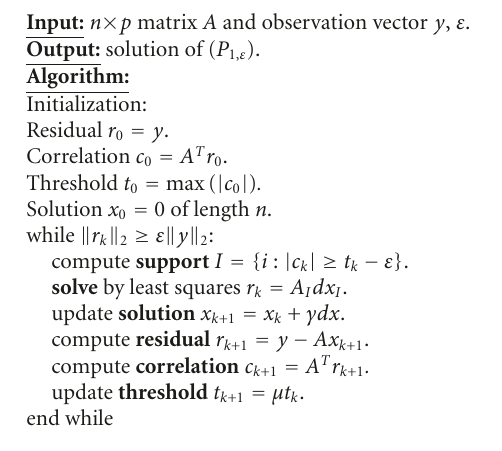
Algorithm 1: Iterative soft thresholding pseudocode.